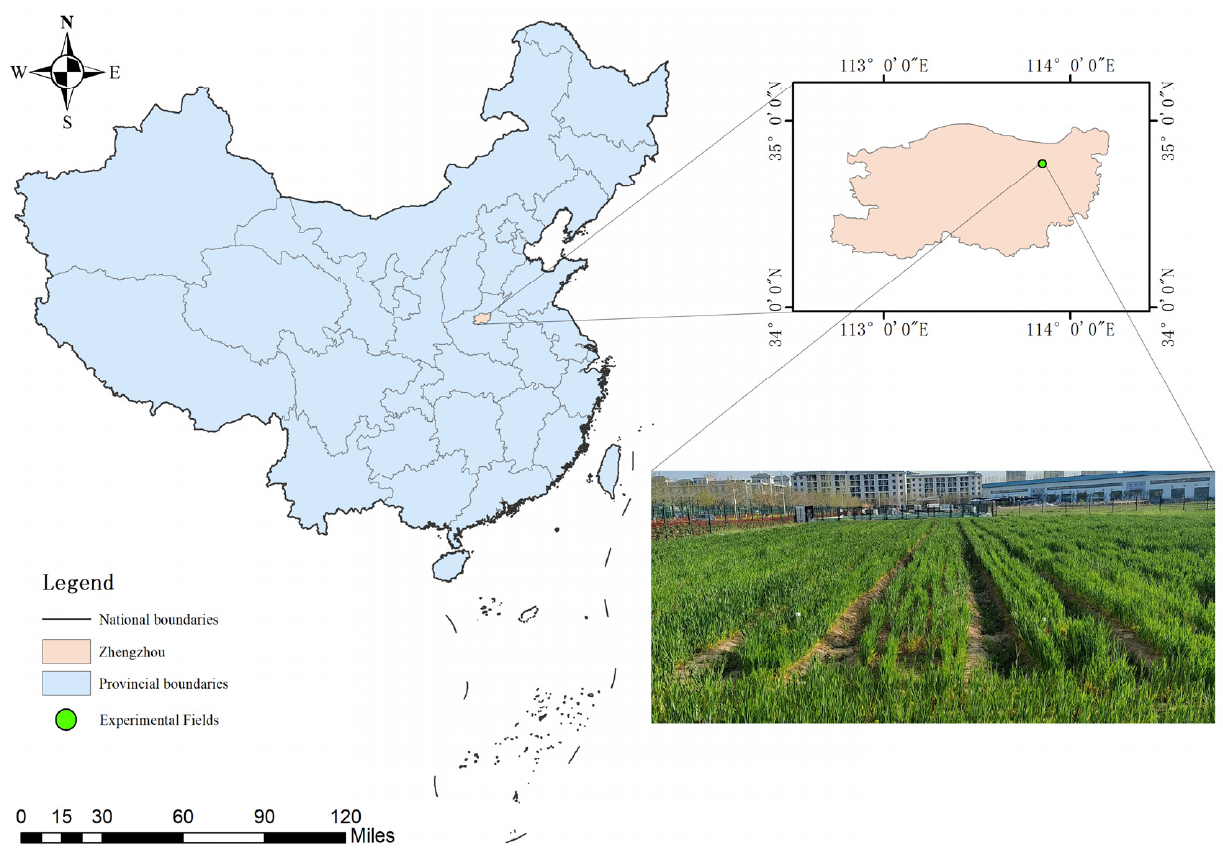
Figure 1. Location of the test area. Table 1. Basic physical properties and physicochemical parameters of